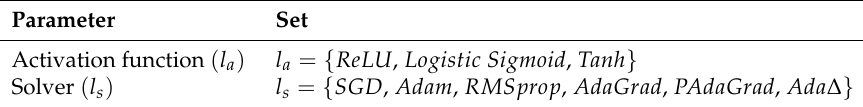
Table 4. String parameters used for chromosome construction.